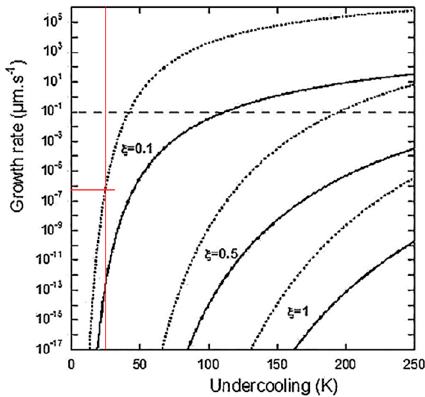
Figure 31. The overall growth rate of a graphite spheroid according to the PNG model as a function of undercooling, for three values of diffuseness, ζ . Dotted lines are on an equation derived based on Hillig’s [119] PNG mechanism and solid lines on an equation based on Zener’s diffusion-controlled growth equation; modified after [118] with permission from Elsevier.